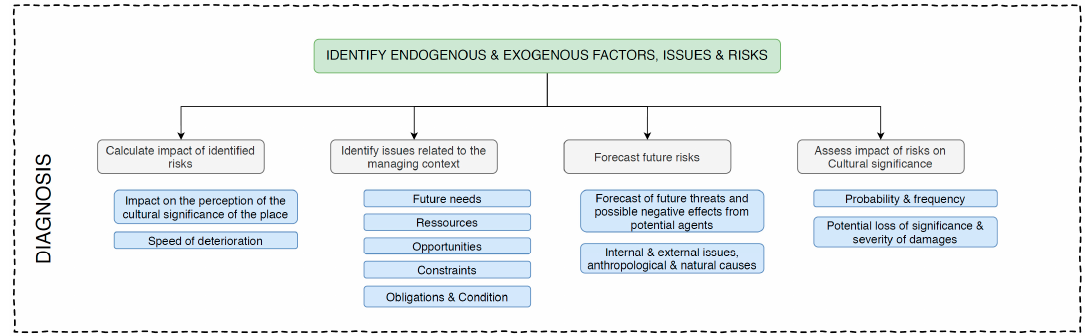
Figure 2. Diagnosis: the first phase of the management plan process.